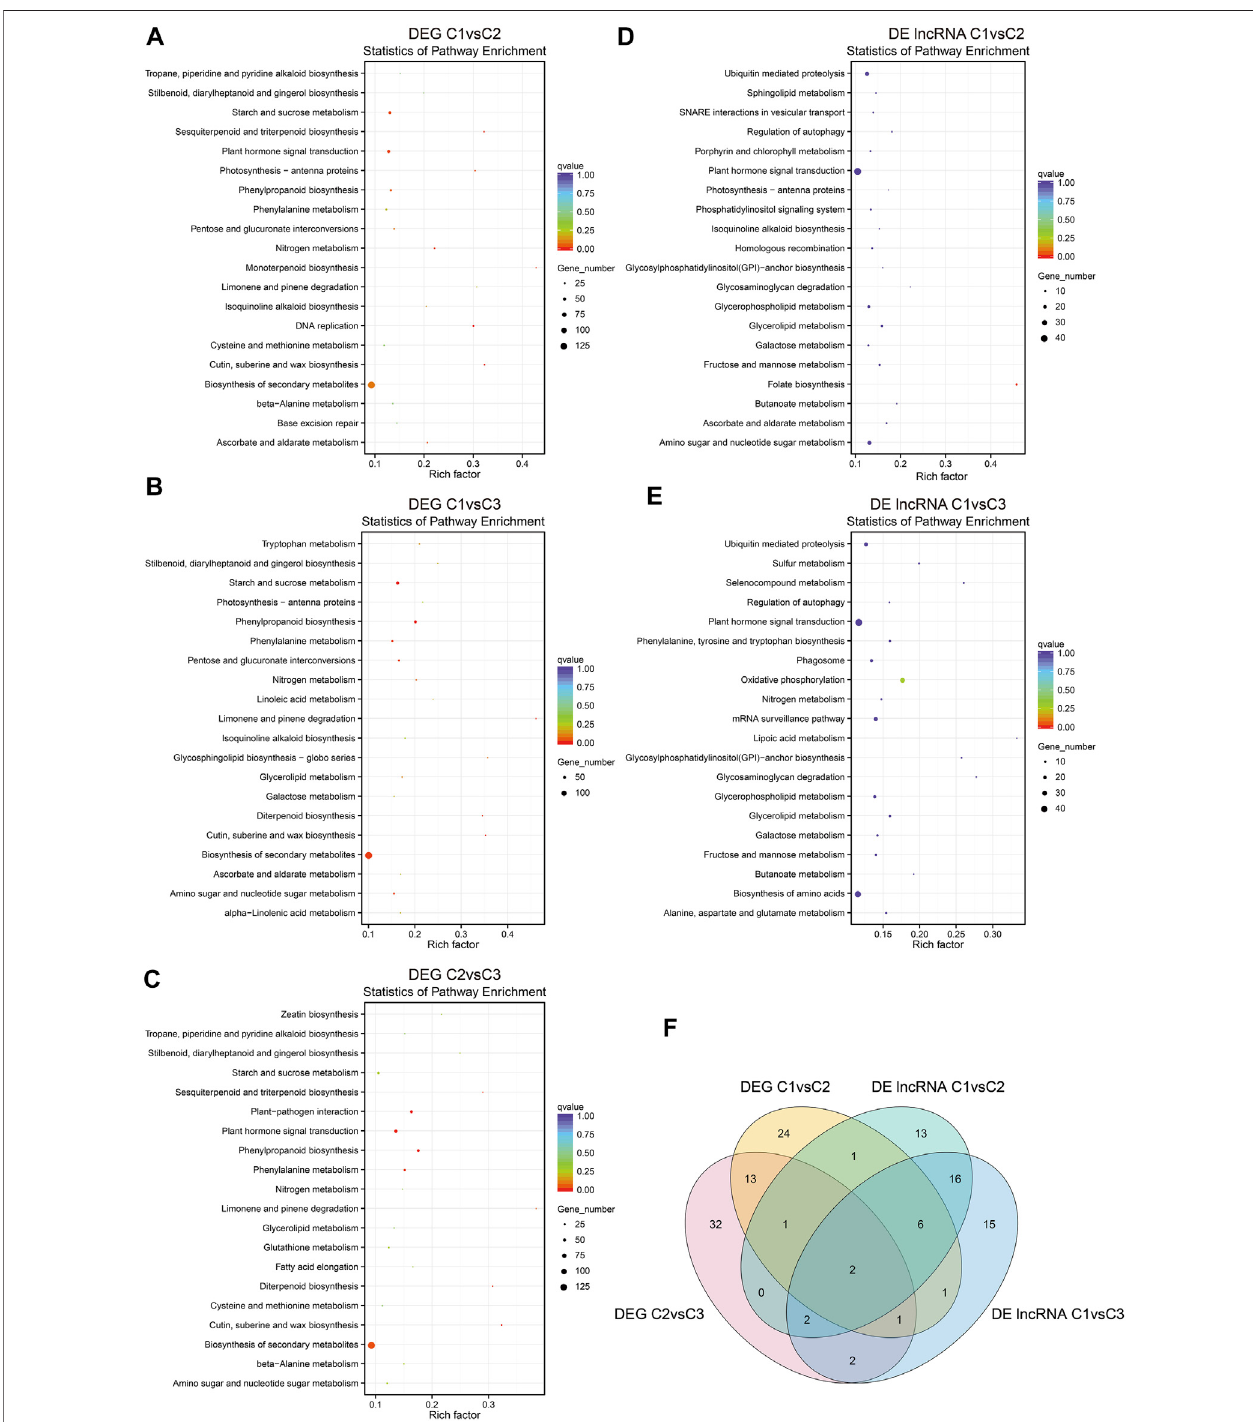
FIGURE 6 | Kyoto Encyclopedia of Genes and Genomes (KEGG) enrichment pathway analysis of DEGs and DE lncRNA cis-acting target genes in hickory female fl oraldevelopment. (A – C) KEGGenrichmentofDEGsinC1vsC2,C1vsC3,andC2vsC3.Onlythetop20enrichedpathwayswereshowninthegraphs. (D,E) Thetop20 enriched pathways of the DE lncRNA cis-acting target genes in C1vsC2 and C1vsC3. (F) Venn diagram showing the number of unique and shared genes for DEGs and the cis-acting target genes of DE lncRNAs in the phytohormone signal transduction pathway in hickory female fl oral development. The x -axis and the y -axis represent the enrichment factors and the pathways, respectively. The different sizes of the dots indicate the number of genes in a pathway.